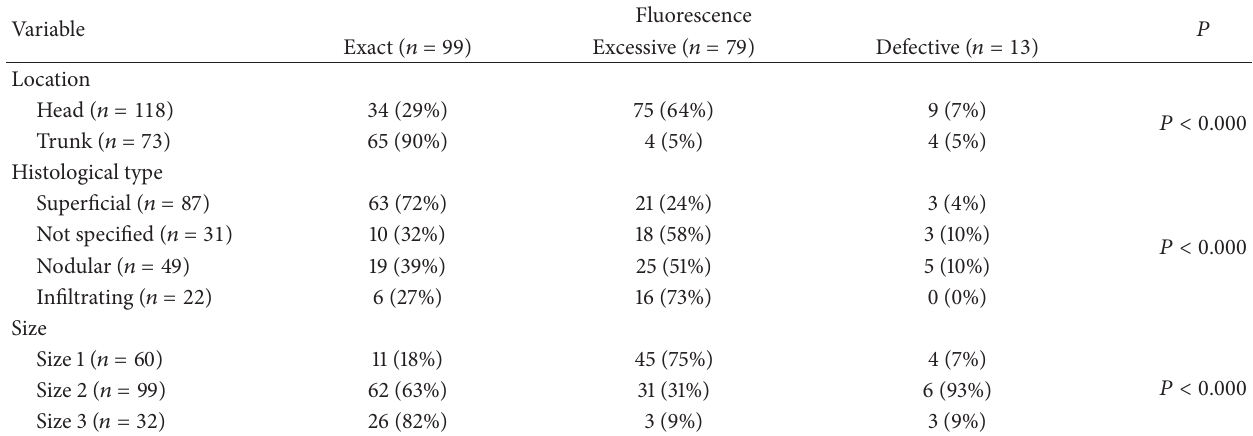
Table 3: Fluorescence pattern based on the variables